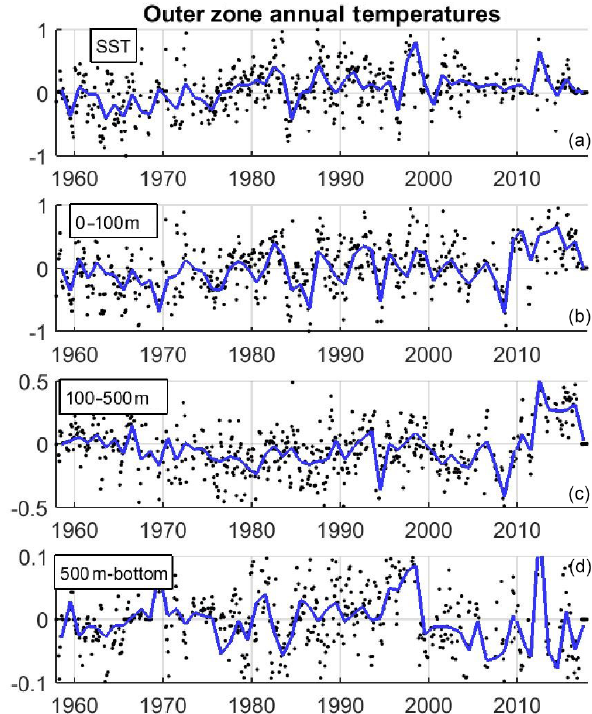
Figure 16. Time series of yearly averaged temperature (in ◦ C) in different layers (a) SST, (b) 0–100m, (c) 100–500m and (d) 500m bottom, in the outer region. Black dots indicate the monthly values with formal error below 0.2 ◦ C. Note the different vertical axis in each